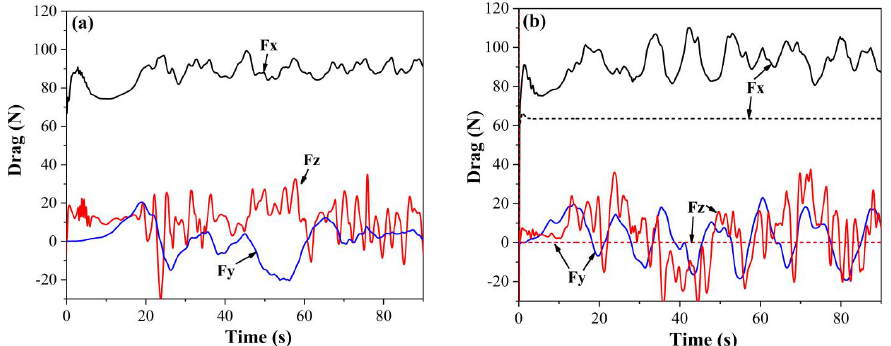
Figure 5. Evolution of the three force components with time at mesh number of about 11 million using the RNG k − ε turbulence model: ( a ) non-overlapping mesh for HG1 and ( b ) overlapping mesh; mesh; solid lines for HG1 and dashed lines for HG3. solid lines for HG1 and dashed lines for